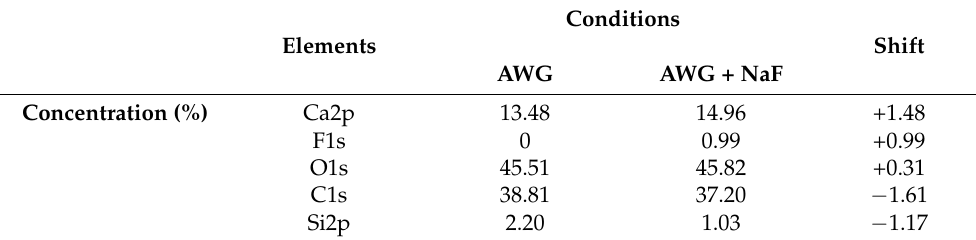
Table 5. Relative content of surface elements of calcite treated with different